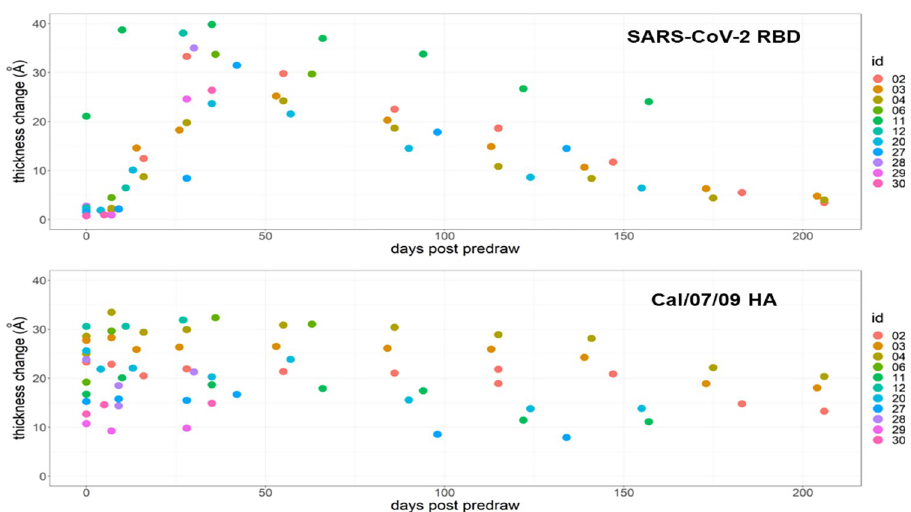
Fig 6. Antibody duration and waning following COVID-19 vaccination. The eleven subjects plotted here (coded by color) all followed the criteria of having a baseline sample collected before receiving the vaccine (predraw) and samples collected one week after first dose and one week after second dose of vaccine. Day 0 is the baseline (predraw) value. Circulating antibodies against the SARS-CoV-2 RBD protein increased with vaccination and decayed over time. Antibody response against the influenza strain A/California/07/2009 hemagglutinin protein had larger variance between samples and response remained similar over time. (S3 Fig), and the correlation between them is very high and positive (R 2 = 0.93) (Fig 5G). Many antibody-binding responses are the array were not strongly correlated. For example, SARS-CoV-2 RBD and Influenza A Beijing hemagglutinin have a negligible correlation (Fig 5H), which is expected because these viruses are from different phylum. Comparing antibody responses across all of the proteins on our array from longitudinal samples enables comparisons of antibody duration and waning. Fig 6 presents SARS-CoV-2 RBD and influenza strain A/California/07/2009 hemagglutinin protein antibody levels over time. The individuals included in this analysis met the criteria of having a baseline sample col- lected immediately before receiving the vaccine and samples collected one week after first dose and one week after second dose of vaccine. Some individuals also went on to have monthly blood draws thereafter. Most of these individuals had not been infected with Covid-19 prior to this study, with the exception of VN11. Circulating SARS-CoV-2 RBD antibody levels in VN11 were initially higher than the other, na ï ve subjects shown in this figure, and immediately increased one week after receiving the first vaccine dose. The na ï ve subjects did not show an increase in circulating antibodies against SARS-CoV-2 RBD one week after the first vaccine dose, but had a robust response after the second dose, which is consistent with findings from clinical trials [34, 35]. The waning of SARS-CoV-2 RBD antibodies over time agrees with other studies showing circulating antibody levels returning close to baseline after 6 months or around 200 days [46]. At day 0, the variance in the number of antibodies present against influ- enza is greater than against SARS-CoV-2 RBD, but the overall level of influenza antibodies was significantly higher. This was expected because these strains of influenza infections and vac- cines have been circulating for over a century, and most if not all individuals have been exposed to them throughout their lifetimes. In contrast, SARS-CoV-2 is a new strain of coro- navirus. People who receive influenza vaccinations generally retain influenza-specific IgG anti- bodies for around two years [47], and cross-reactive antibodies to other strains will make this appear higher.